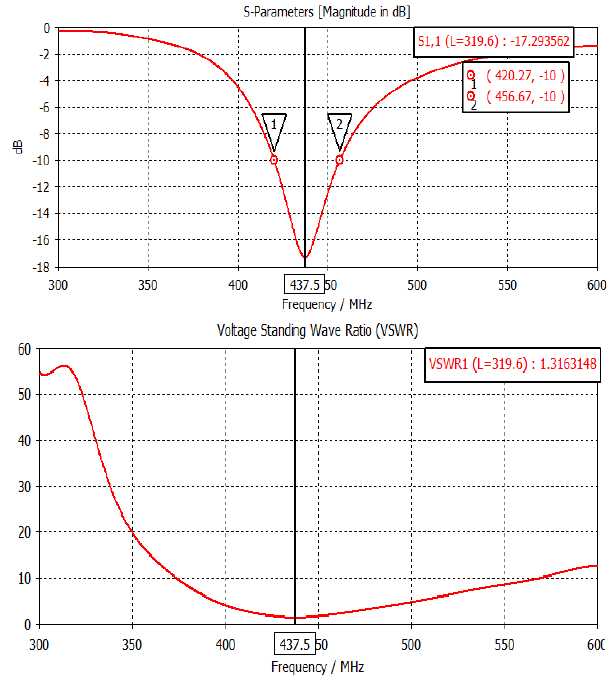
Figure 11(a) and 11(b). VSWR and S11 plots for the optimized model of the half-wave dipole antenna with the metallic structure integrated